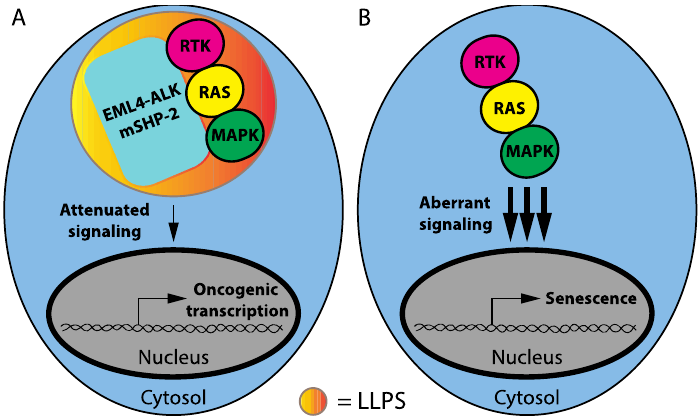
Figure 2. Phase separation attenuates oncogenic signaling, avoiding cellular senescence. ( A ) LLPS implication in attenuation of RAS-MAP kinase signaling. ( B ) LLPS absence leading to aberrant RAS-MAP kinase signaling and the senescence